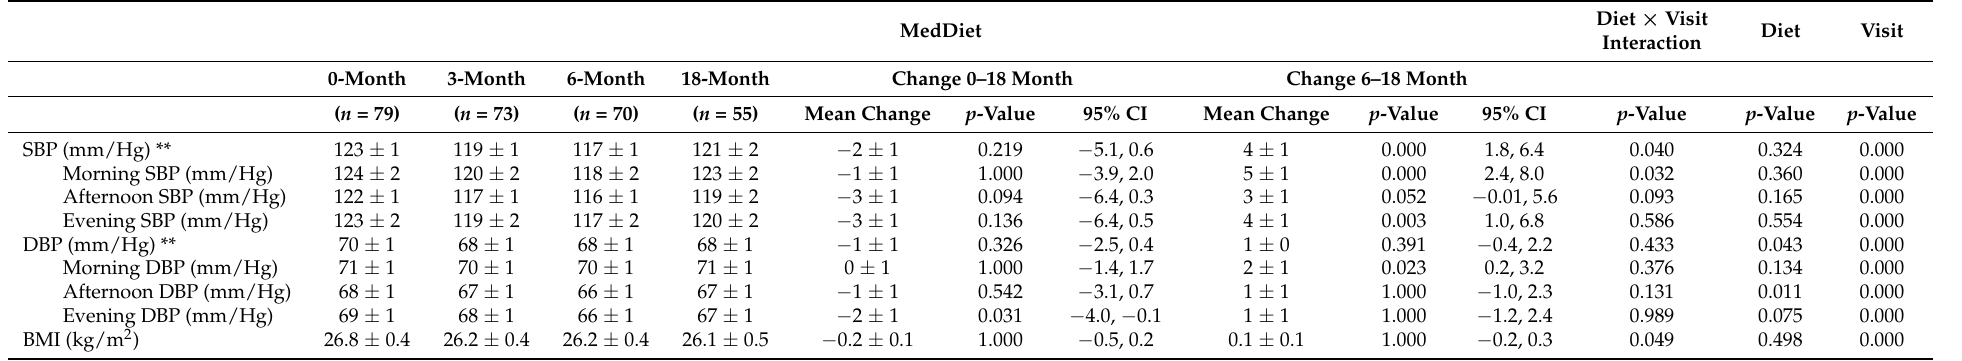
Table 2. Clinical outcomes at baseline (0-months) and during 6 months dietary intervention (measured at 3 and 6 months) and 12 months after intervention was ceased (18